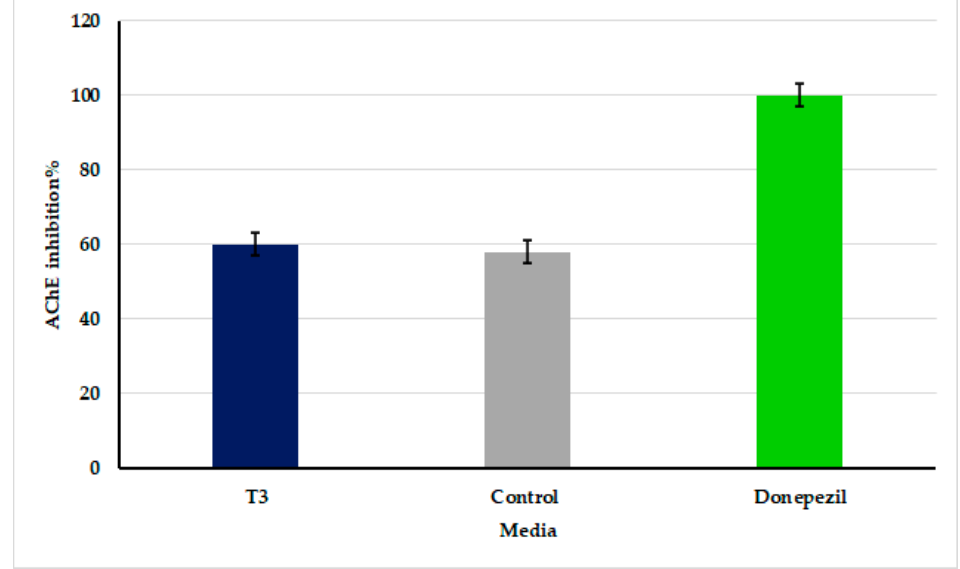
Figure 6. The AChE inhibitory activity of O. sancta crude extracts grown on Zarrouk’s medium (control) and 12.5% modified Zarrouk’s medium concentration (T3).